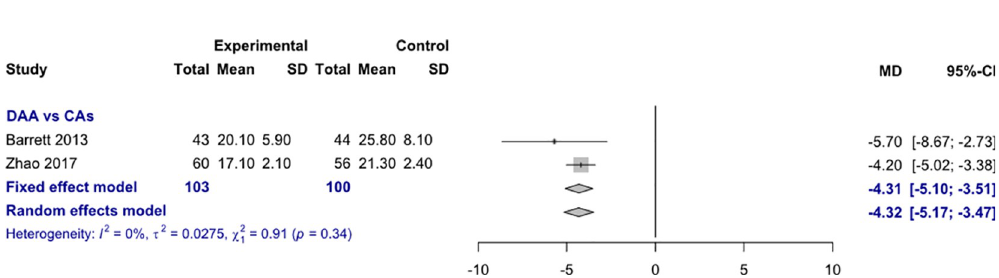
Fig 9. Comparison of the acetabular cup anteversion angle in degrees. DAA, direct anterior approach; CAs, conventional approaches; SD, standard deviation; MD, mean difference; CI, confidence interval.